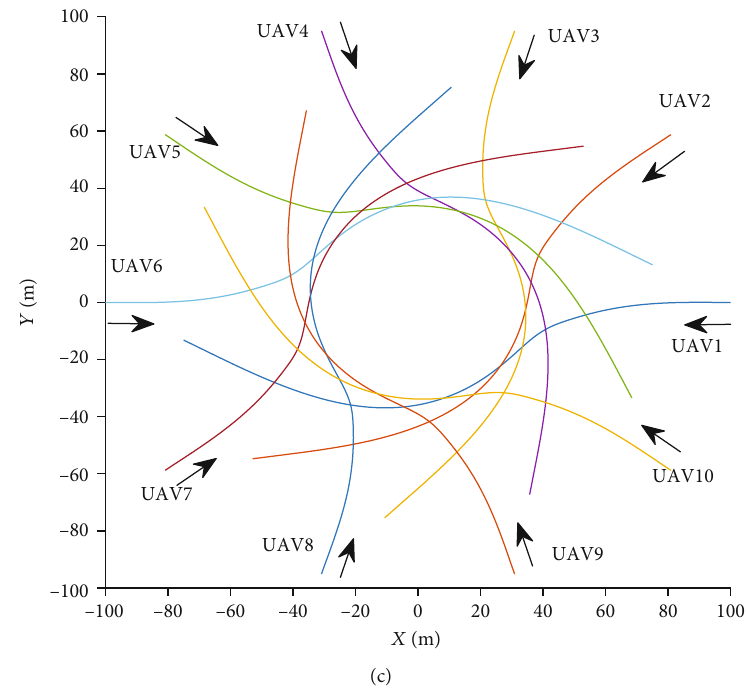
Figure 8: Con fl ict resolution strategies based on APF: (a) 2 UAVs ’ con fl ict, (b) 6 UAVs ’ con fl ict, and (c) 10 UAVs ’ con fl